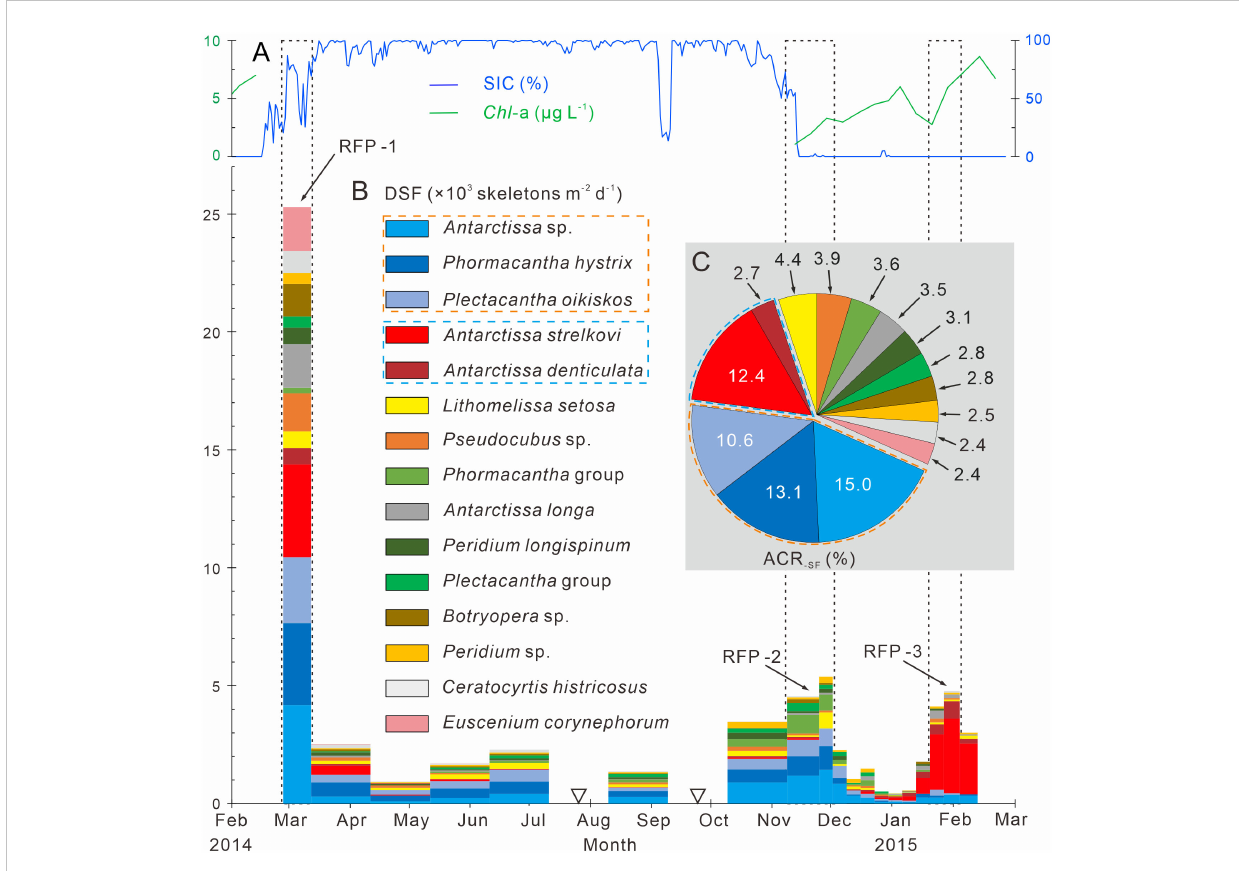
FIGURE 4 Time-series variations of the dominant species fl uxes, SIC (%) and Chl- a (µg L − 1 ) in Prydz Bay polynya. (A) SIC (%) and Chl- a (µg L − 1 ). SIC data were retrieved from the University of Bremen (http://www.iup.uni-bremen.de:8084/amsr2); Chl -a data from the Aqua-MODIS products (http://hermes. acri.fr). (B) DSF, dominant species fl ux. RFP-1 – 3 are the three radiolarian fl ux peaks, (black dotted boxes). The width of each histogram box indicates the sampling interval, and black hollow inverted triangles mark samples that were not analyzed because the sample size was too small. Orange and blue dotted boxes indicate dominant assemblages one and two, respectively. (C) ACR -SF , average contribution of each species fl